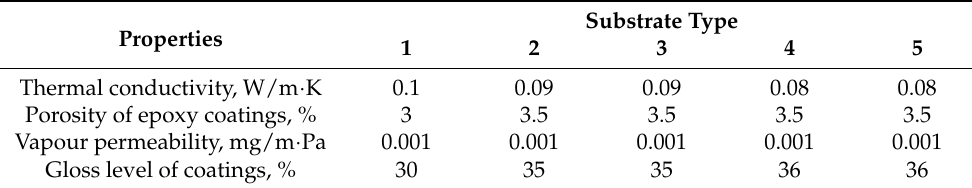
Table 7. Physical and mechanical properties of epoxy coatings from epoxy compositions formed on substrates of the type